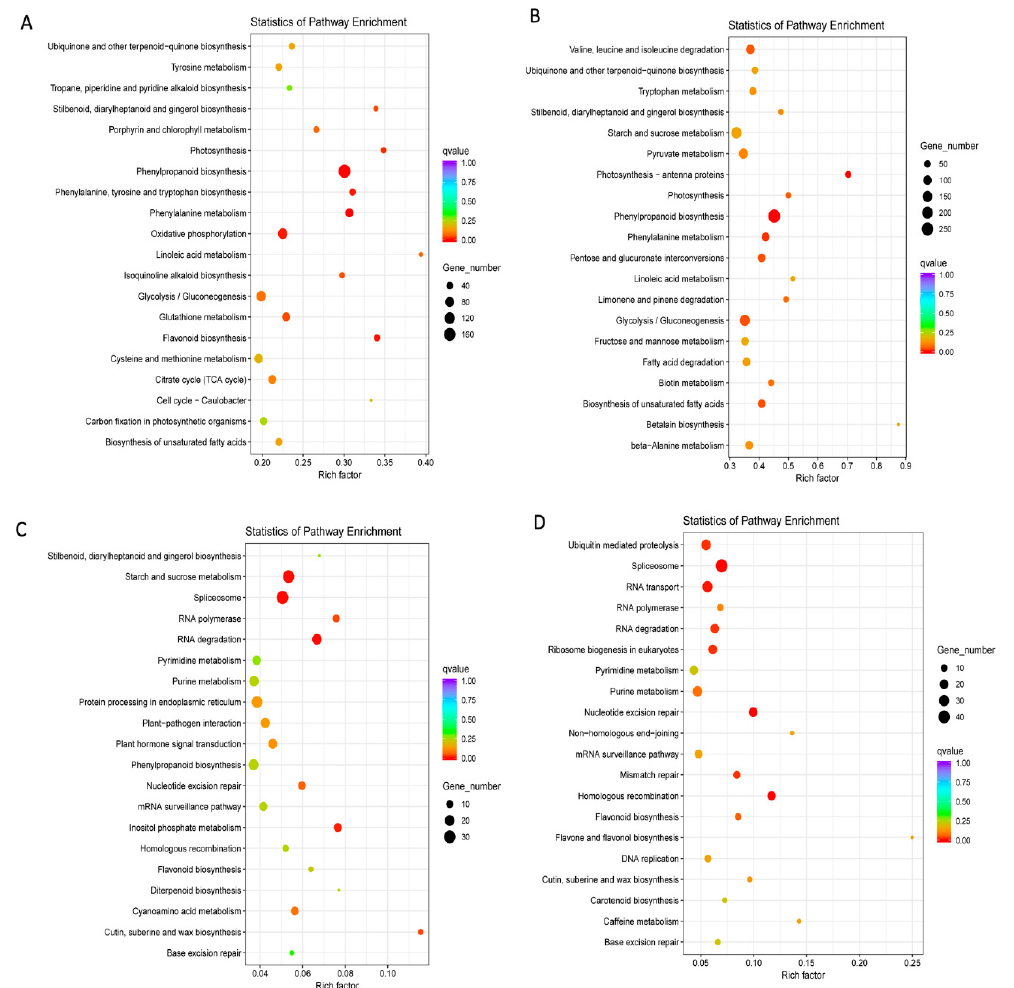
Figure 4. KEGG enrichment analysis of the upregulated DEGs. ( A ) Top 20 enriched pathways of upregulated DEGs in LS comparison setting. ( B ) Top 20 enriched pathways of upregulated DEGs in LR comparison setting. ( C ) Top 20 enriched pathways of downregulated DEGs in LS comparison setting. ( D ) Top 20 enriched pathways of downregulated DEGs in LR comparison setting. The colors are shaded according to the q-values level as shown in the color bars; the size of the circle indicates the number of DEGs.